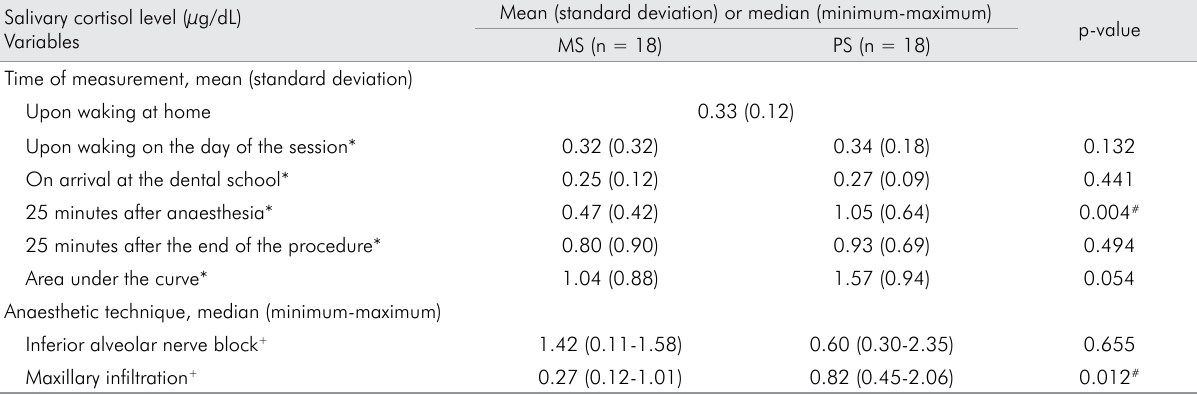
Mean (standard deviation) or median (minimum-maximum)